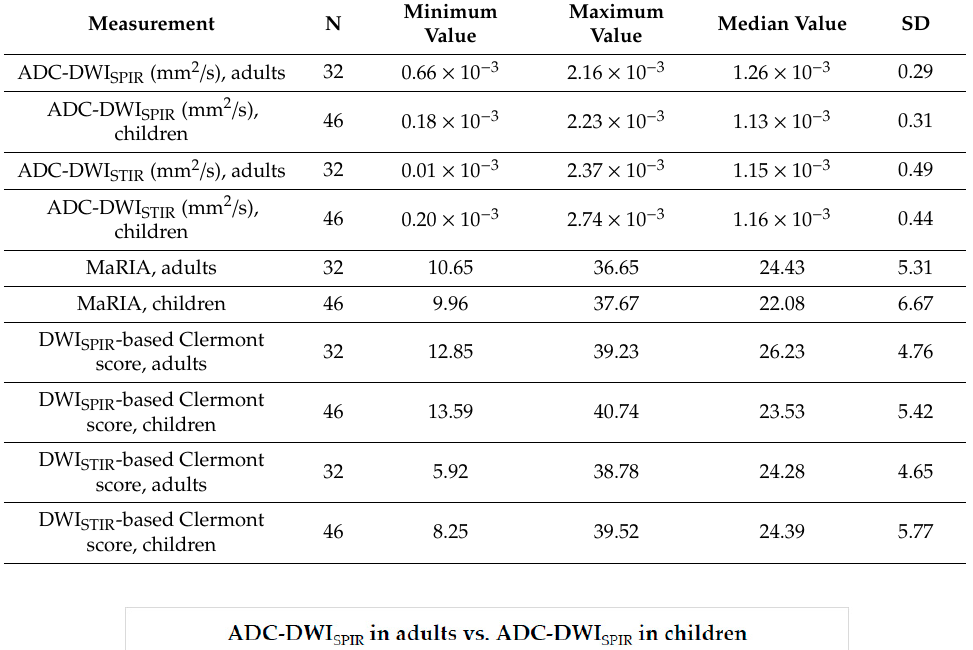
Table 2. Values of ADC-DWI SPIR , ADC-DWI STIR , MaRIA as well as ADC-DWI SPIR and ADC-DWI STIR -based Clermont scores in the groups of adult and paediatric patients.